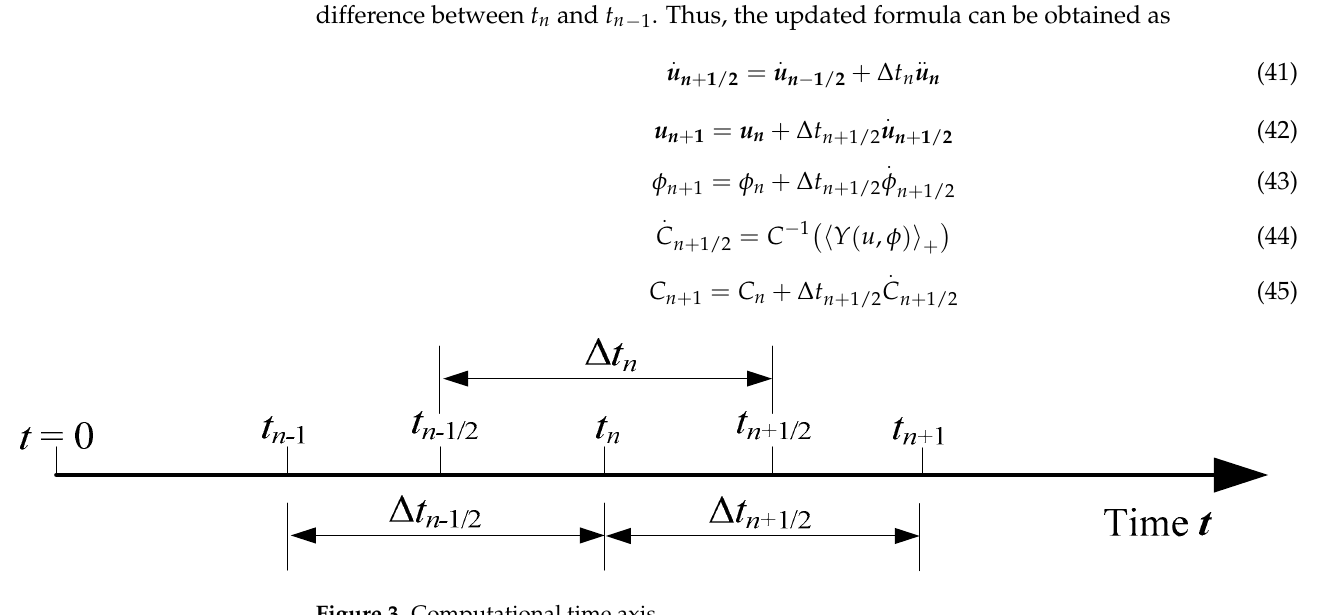
Figure 3. Computational time axis.